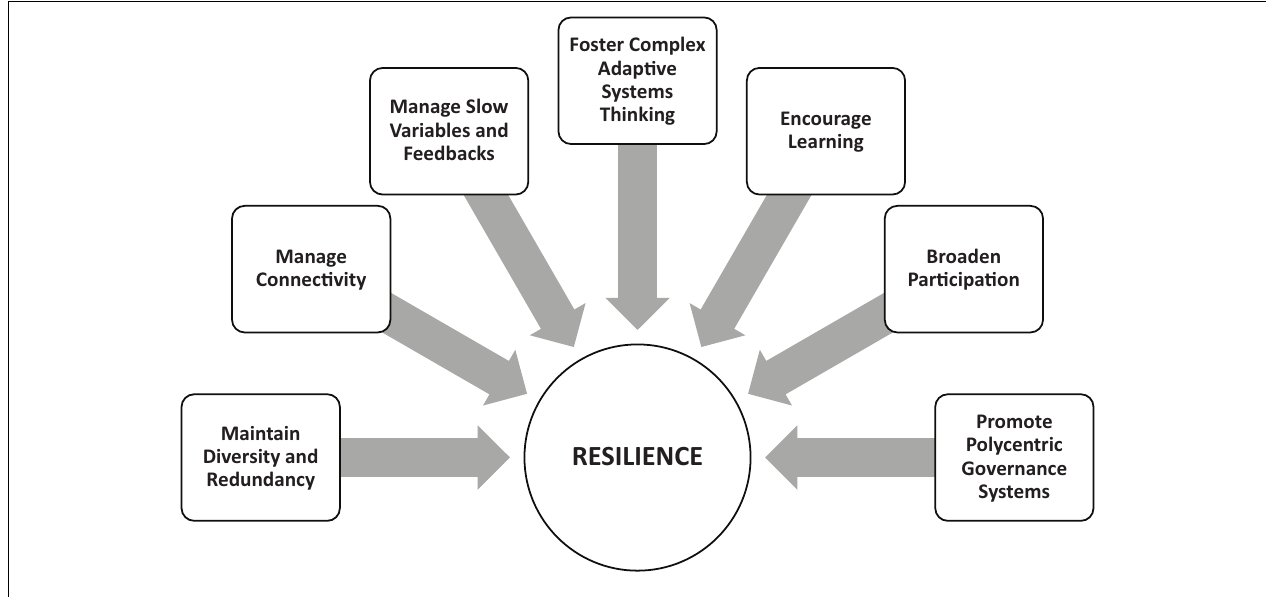
FIGURE 1 | Resilience Principles (graphic by SSY and KMG, based on Biggs et al., 2015).